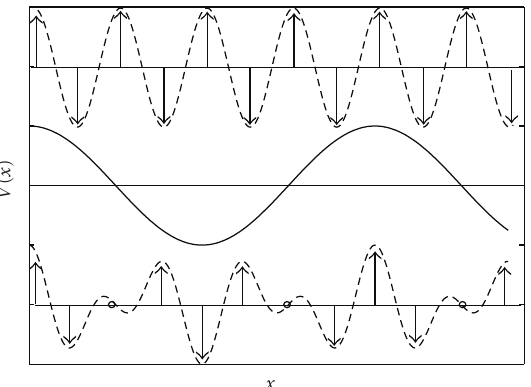
Figure 1: A picture of how stripe-like configurations are made up from the product of two plane wave potentials. The arrows in the upper row show the AFM moments on Cu sites given by the −→ ·−→ envelope function Re(exp( − i Q x )) (broken line), and the unit cell −→ contains 2 Cu sites along x . The second row shows the modulation −→ −→ Re(exp( i q · x ) (here q = Q/ 4) and the last row is the product −→ −→ −→ Re(exp( − i ( Q − q ) · x ) with the new spin configurations on the Cu. The striped unit cell contains 8 Cu sites.